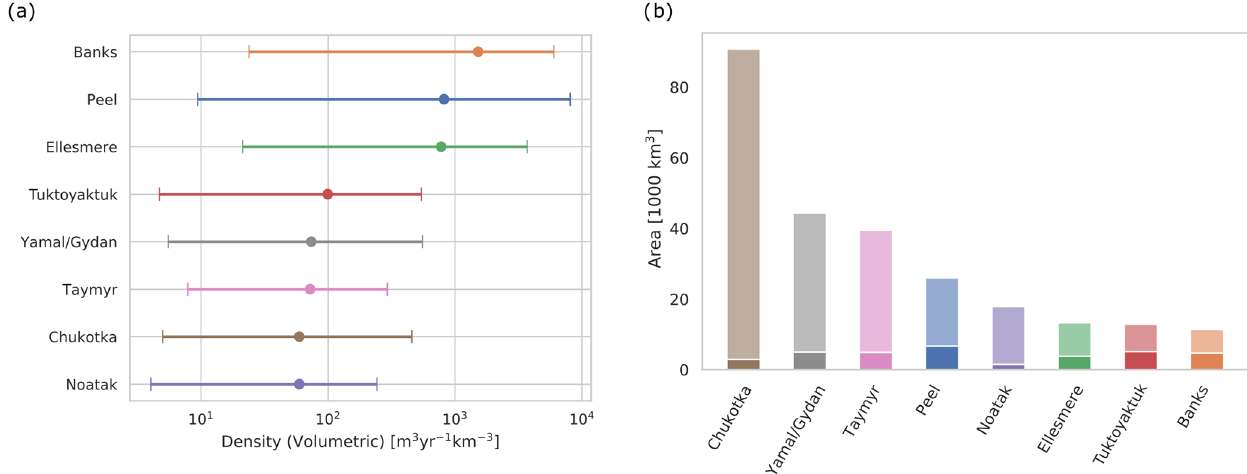
Figure 8. Volumetric change rate densities (a) and density related to study site size (b) for each study site. Panel (a) shows the computed RTS volumetric change rate densities using a 10km by 10km grid with the empty grid cells removed. The vertical bars indicate the range in the computed densities. Panel (b) shows the study site size with the fraction of tiles with RTSs represented by the solid